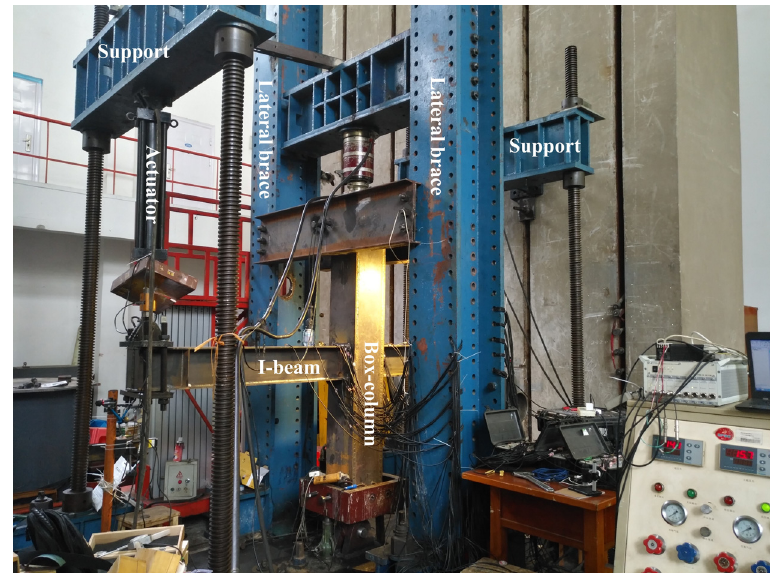
Figure 5. Test setup configuration.